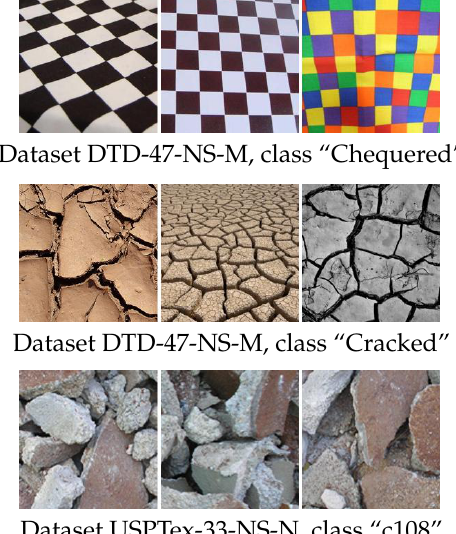
Figure 15. CNN-based features were on the whole better than hand-crafted descriptors at classifying non-stationary textures, as those shown in the